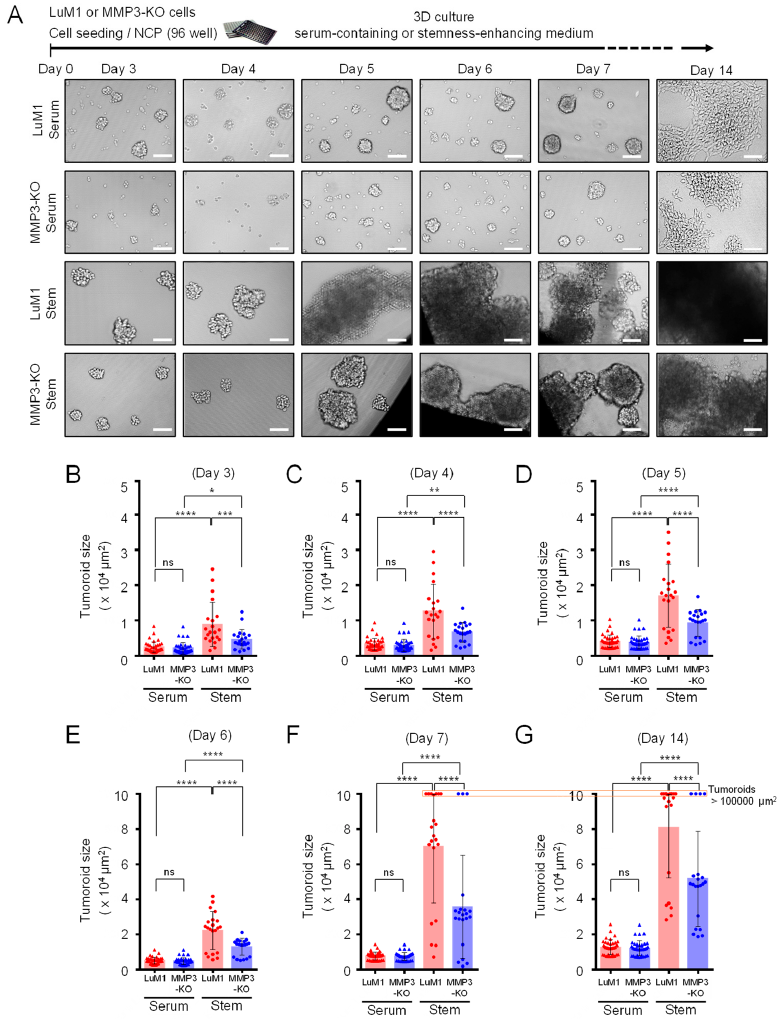
Figure 3 . Loss of the Mmp3 gene reduces the in vitro tumorigenicity. Tumoroids were formed in the NanoCulture Plate (NCP)-based 3D culture with a serum-containing or stemness-enhancing medium. ( A ) Representative images of the LuM1 and MMP3-KO tumoroids. The upper panel shows the experimental design. ( B – G ) Tumoroid size quantification on ( B ) day 3, ( C ) day 4, ( D ) day 5, ( E )